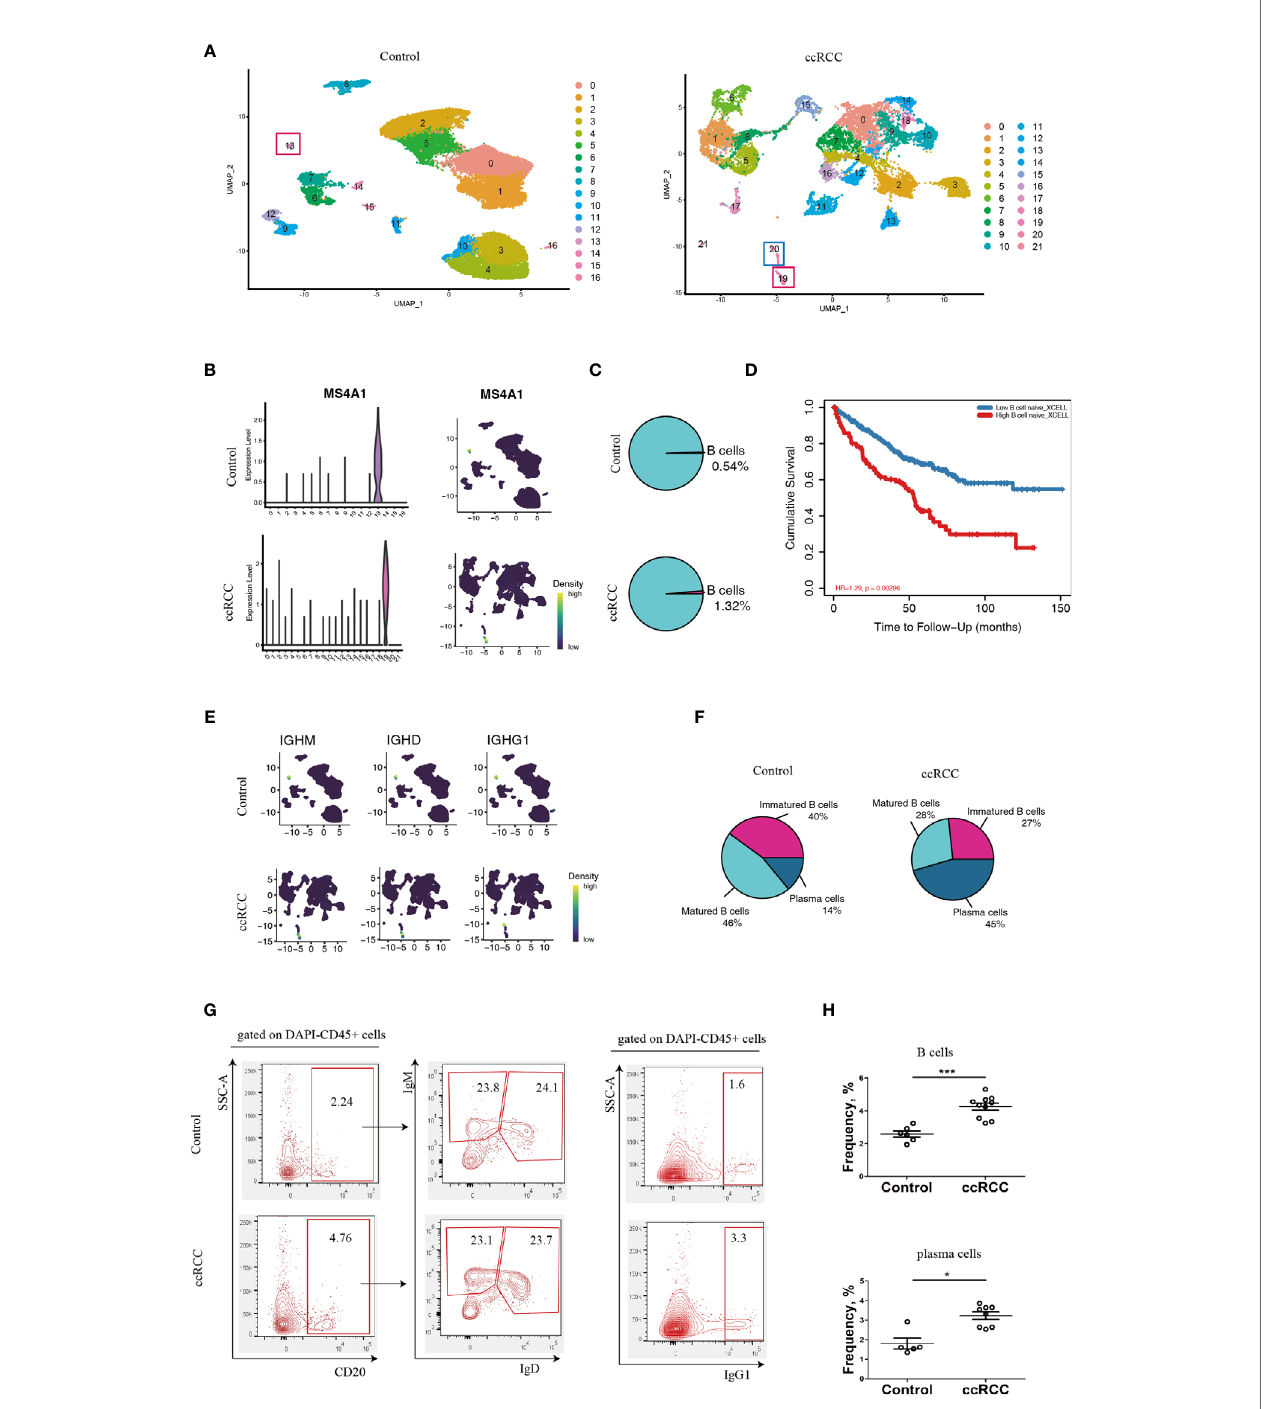
FIGURE 1 | Characterization of B-lineage cells. (A) UMAP plots showing the cellular components in control kidneys and ccRCC biopsies. (B) Left panel: Violin Plots showing the expression level of MS4A1 in control kidneys and ccRCC biopsies; right panel: gene nebula maps showing the expression pattern of MS4A1 in control kidney and ccRCC biopsies. (C) Pie Plots showing the frequency of B cells in control kidneys and ccRCC biopsies. (D) Survival curves showing the correlation between B cell density to prognosis. (E) Gene nebula maps showing the distribution of B cell development marker genes (IGHM, IGHD and IGHG1) in control kidneys and ccRCC biopsies. (F) Pie plots showing the frequency of immature B cells, matured B cells and plasma cells in control kidneys and ccRCC biopsies. (G) Flow cytometry analysis of B-lineage cells in control kidneys and ccRCC biopsies. The left panel shows the gating strategy of immature B and matured B cells; the right panel shows the gating strategy of plasma cells. (H) Scatter plots showing the statistical analysis of B cells and plasma cells in control kidneys and ccRCC biopsies. Each dot represents one readout. The data represent 3 independent experiments. *p<0.05,